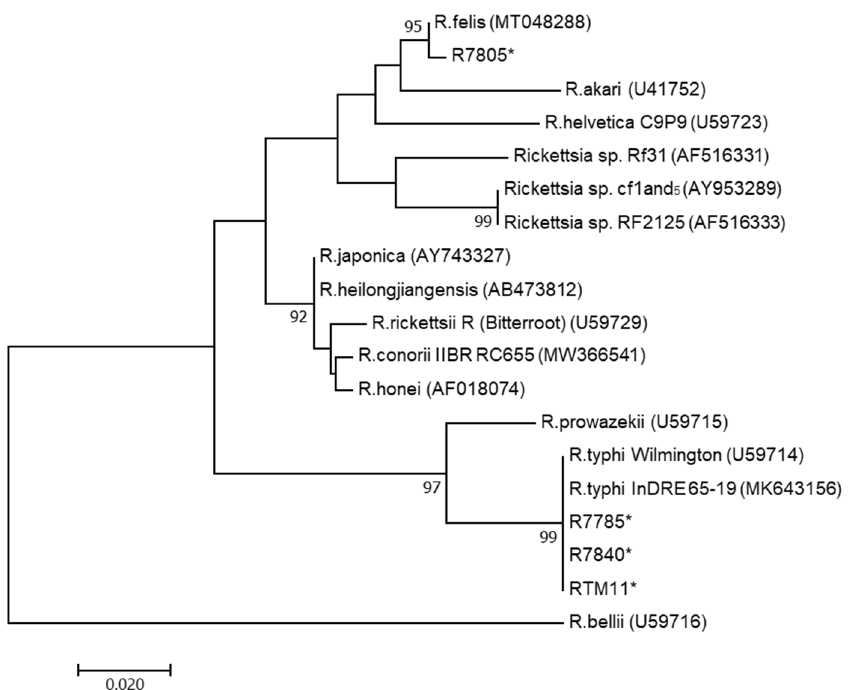
Figure 2. Unrooted phylogenetic reconstruction of the rickettsial gltA gene using the maximum likelihood method based on the Tamura 3-parameter model. The tree topology is drawn to scale, with branch lengths indicating the number of substitutions per site. Bootstrap values higher than 70% are indicated. Positive samples are denoted (*) after the sample ID (R7785, R7805, R7840, and RTM11 belong to the Rattus rattus complex).